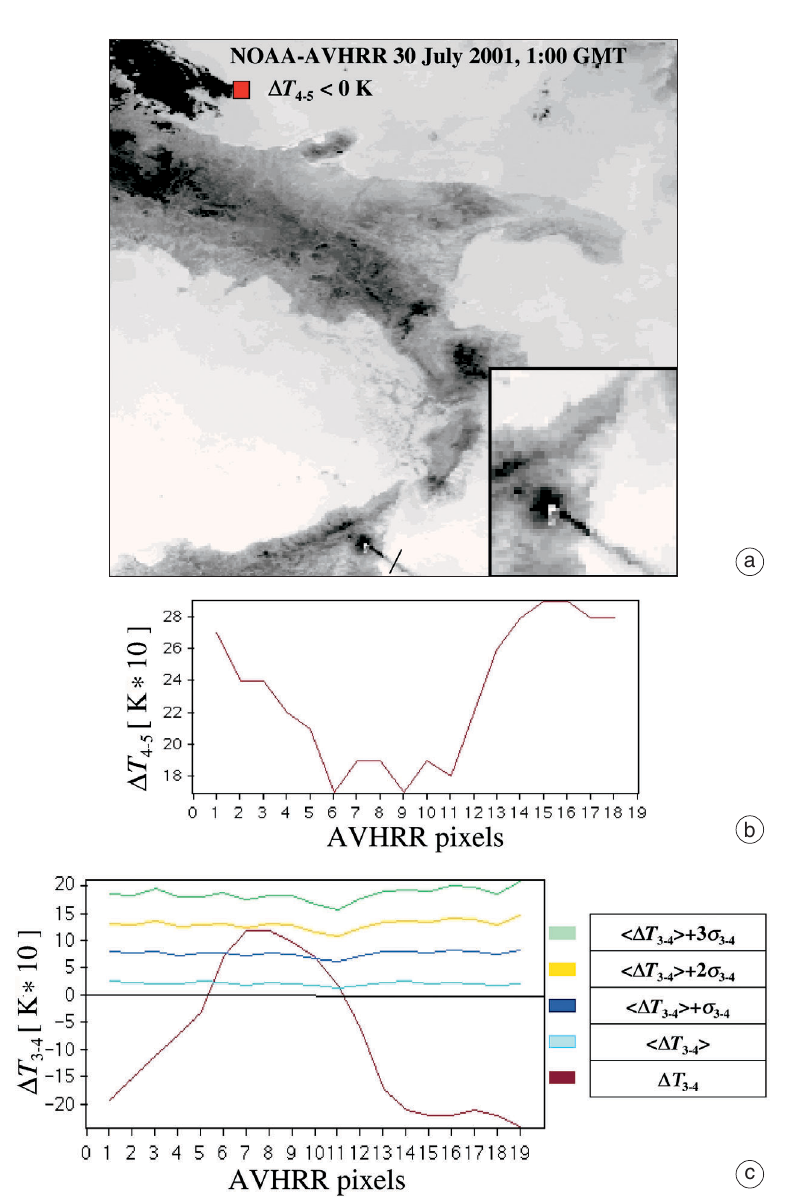
Fig. 2a-c. NOAA/AVHRR July 30th 2001, 1:00 GMT: a) as in fig. 1a; b) plots of ∆ T 4 − 5 signal across the transect drawn in (a): note as ash plume exhibits only positive ∆ T 4 − 5 values being completely undetected by Prata’s fixed threshold test; c) ∆ T 3 − 4 signal (see text) is plotted together with its reference values correspon- ding to ⊗ 3 − 4 ( x , y , t ) cuts at values in between 0 ( i.e. ∆ T 3 − 4 = 〈∆ T 3 − 4 〉 ) and 3 ( i.e. ∆ T 3 − 4 = 〈∆ T 3 − 4 〉 + 3 σ 3 − 4 ). Note how the presence of the ash plume is detectable by RAT approach also on the basis of ⊗ 3 − 4 ( x , y , t ) in- dex (see